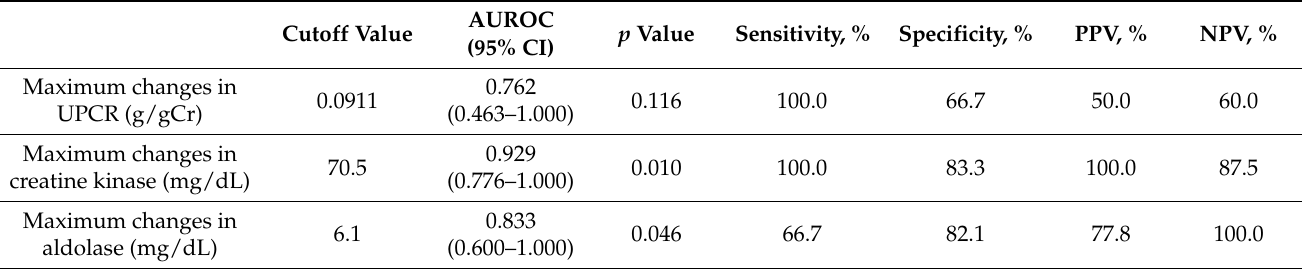
Table 5. ROC curve analysis of each parameter and prediction of high-maximum C trough ( ≥ 929.0 ng/mL).